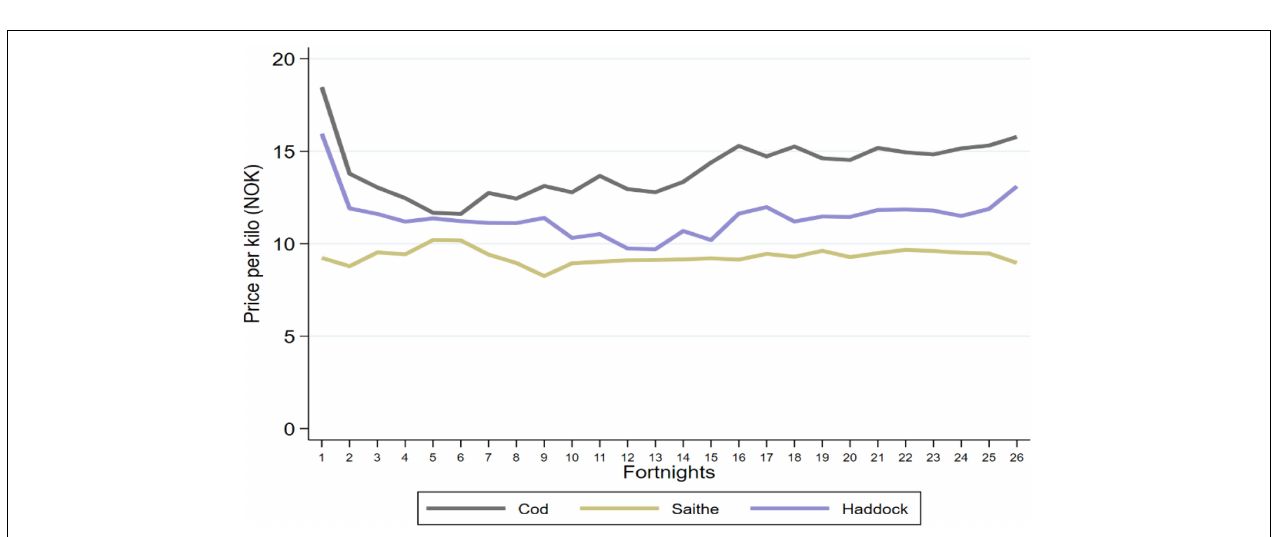
FIGURE 5 | The bar graph shows the probabilistic catch per unit of effort (CPUE) in regions A, B, and C on a fortnightly basis. The probabilistic values of CPUE obtained from a convex combination of zero and a log-normally distributed random variable with mean and standard deviation depending on harvesting time, its location and target